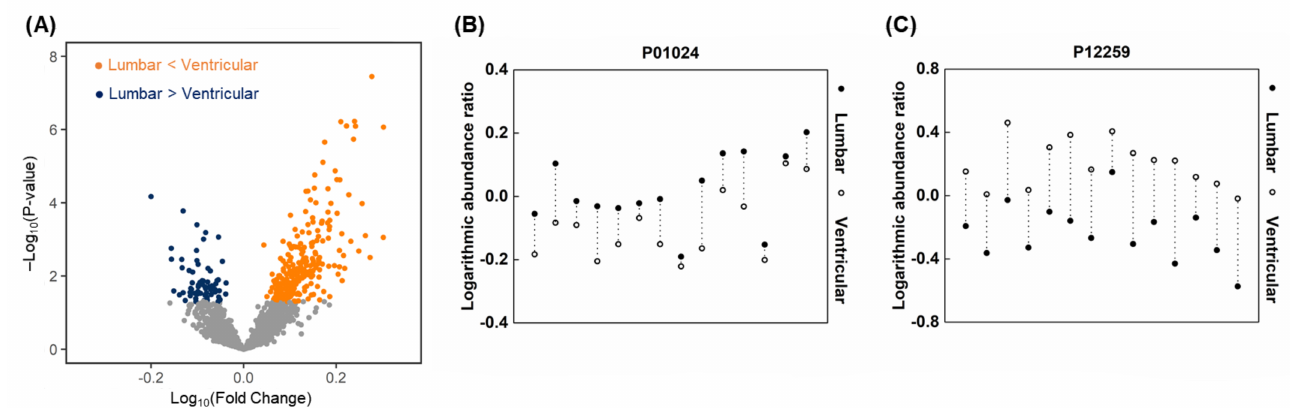
Figure 4. Evaluation of differentially expressed proteins between lumbar and ventricular CSF. ( A ) Volcano plot illustrating significantly discriminative proteins for each compartment. X-axis: Log 10 (mean abundance of ventricular/mean abundance of lumbar). Y-axis: − Log 10 (paired t -test p -value). Proteins with 2-group t -test p -value < 0.05 are presented in navy or orange color dots. An example of proteins ion highly expressed in ( B ) lumbar and ( C ) ventricular CSF by paired comparisons from each patient (n =